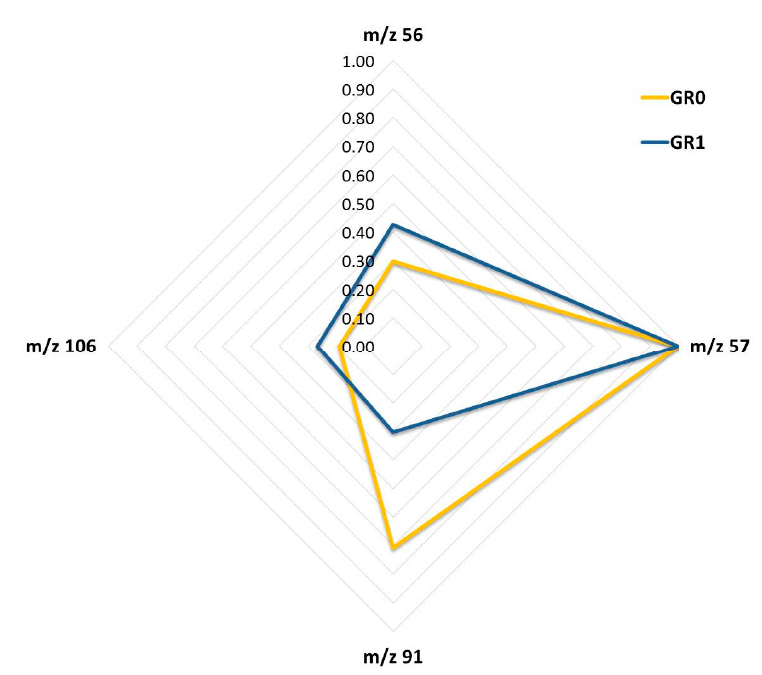
Figure 3. Spider Chart with the mass-to-charge ratio ( m / z ) values selected by the linear discriminant analysis (LDA).